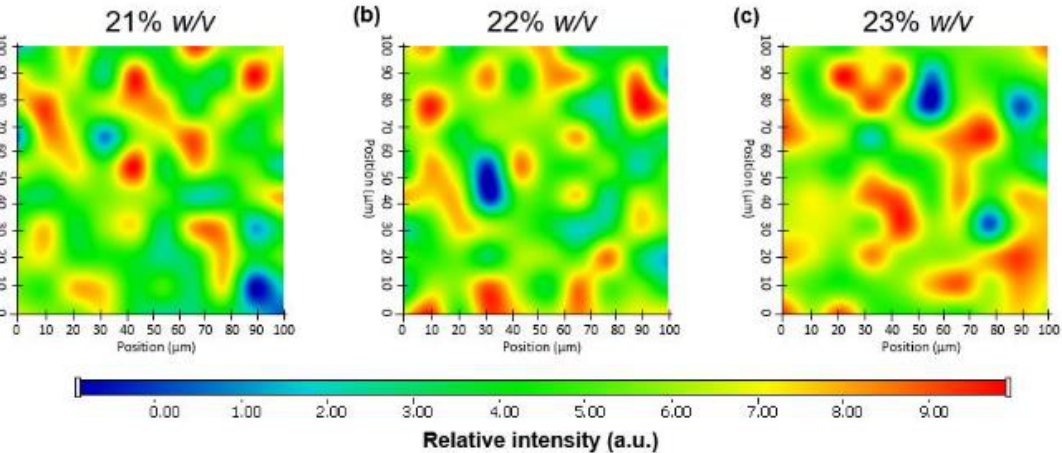
Figure 5. Raman chemical mapping of AMT-BSA in the in situ gelling matrices with different